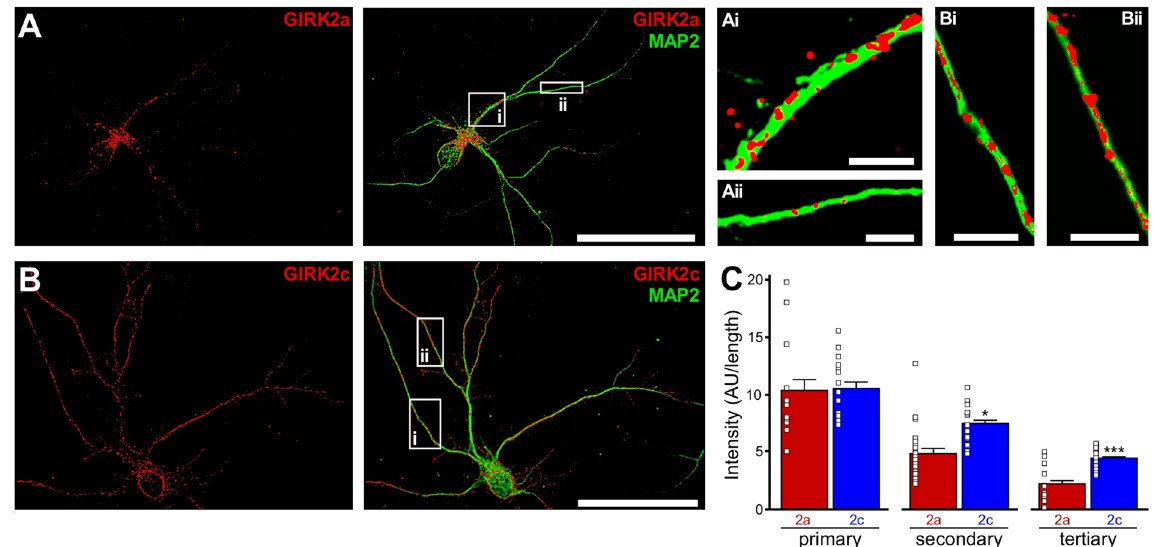
Figure 3. Subcellular distribution of GIRK2a and GIRK2c in Girk2 − / − pyramidal neurons. ( A,B ) Representative images showing GIRK2 (red) and MAP2 (green) immunolabeling, and their overlay, in Girk2 − / − hippocampal pyramidal neurons expressing either GIRK2a ( A ) or GIRK2c ( B ). Scale bars: 50 microns. The insets highlight different densities of GIRK2a and GIRK2c puncta along proximal/primary (Ai,Bi) and distal/ secondary (Aii,Bii) dendritic segments. Scale bars: 5 microns. ( C ) Quantification of GIRK2a and GIRK2c labeling in dendrites from infected Girk2 − / − pyramidal neurons. GIRK2 fluorescence intensity was measured in 2–3 primary ( t 27 = 1.4, P = 0.17), secondary ( t 29 = 2.1, * P < 0.05), and tertiary ( t 27 = 5.2, *** P < 0.001) dendritic segments from 5 different neurons expressing each subunit. Fluorescence intensity is expressed as arbitrary units (AU) normalized to segment length. Only GIRK2 labeling that overlapped directly with the dendritic segment (identified by MAP2 labeling) was quantified in this